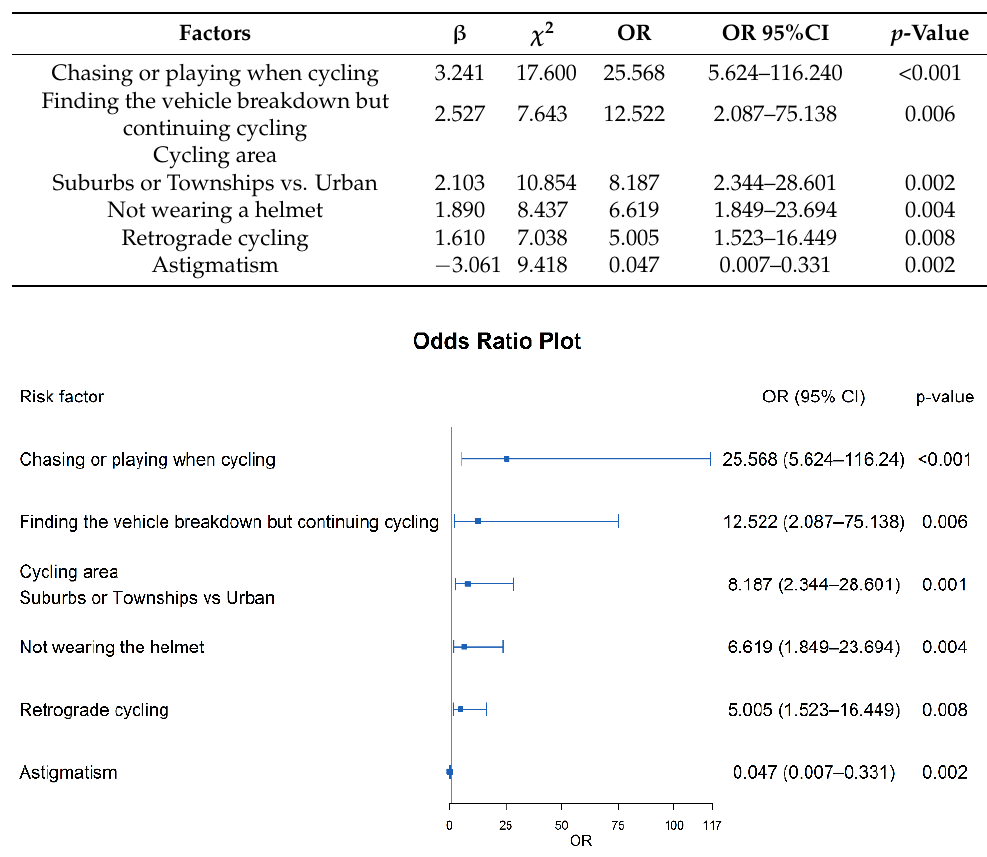
Table 4. Multivariable logistic regression analysis on case-control study of ERTIs.